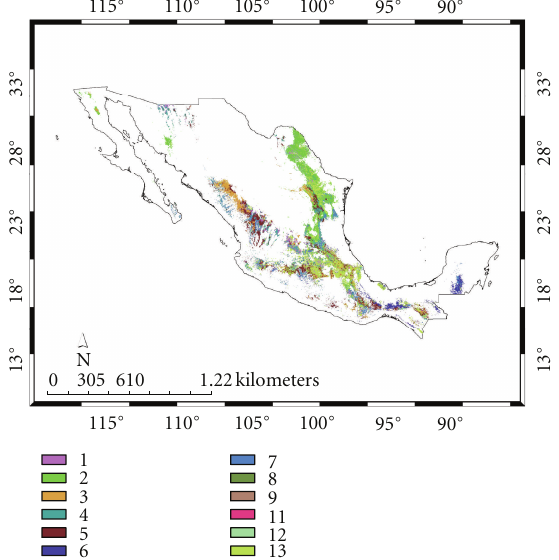
Figure 9: Species distribution model and vegetation types for the Ixodes group: (1) grassland; (2) scrubland; (3) pine forest; (4) oak forest; (5) pine-oak forest; (6) tropical rainforest; (7) tropical deciduous forest; (8) aquatic inland vegetation; (9) cloud forest; (10) mangle; (11) palms/palm plantations; (12) savanna; (13) other vegetation types/not